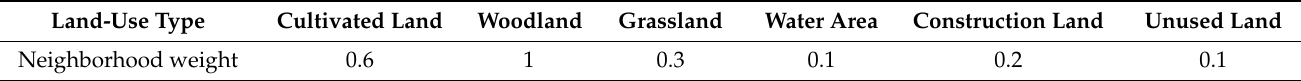
Table 3. The neighborhood weights of different land-use